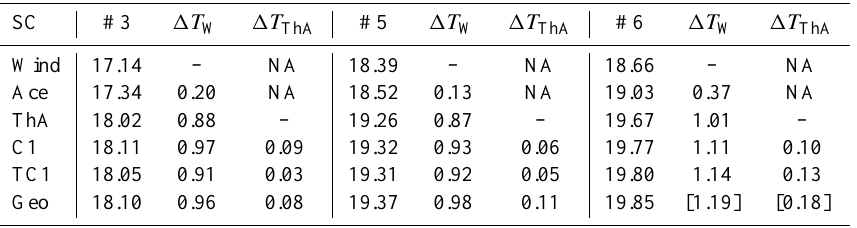
Table 2. Time differences between different spacecraft of observed magnetic structures. Shown are the times of observation in decimal hours and the differences of all spacecraft with Wind (the furthest out) and the differences between all magnetosheath spacecraft and ThA (nearest the bow shock).